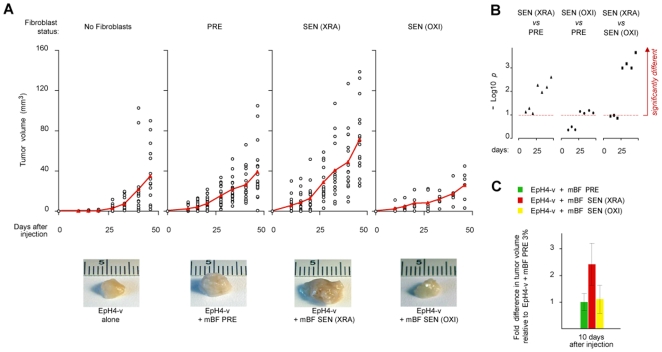
SEN(XRA) but not SEN(OXI) mouse cells promote tumorigenesis in vivo.A) EpH4-v epithelial cells were injected into the mammary fat pad area of nu/nu mice alone or with mouse breast fibroblasts made senescent in 3% or 20% O2. Tumor volumes were determined as described in Methods. Number of mice used: PRE, 3% O2: n = 20; SEN(XRA), 3% O2: n = 16; SEN (OXI), 20% O2: n = 6; EpH4-v alone: n = 17. B–C) Comparison of average tumor volumes after injection. B) Significant differences between different tumor populations are graphically represented as -Log10(p) where p = 1. Student t-test value, and significance (p>0.9) is shown by the dashed line (see Fig. S6 for all Student t-test values and tumor population comparisons). C) Average fold-differences 10 d after injection.